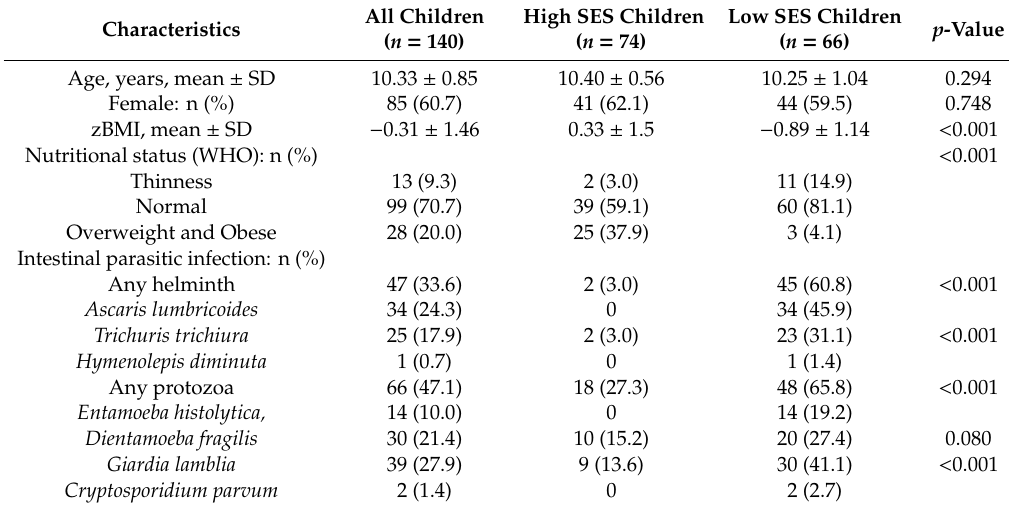
Table 1. Characteristics of study